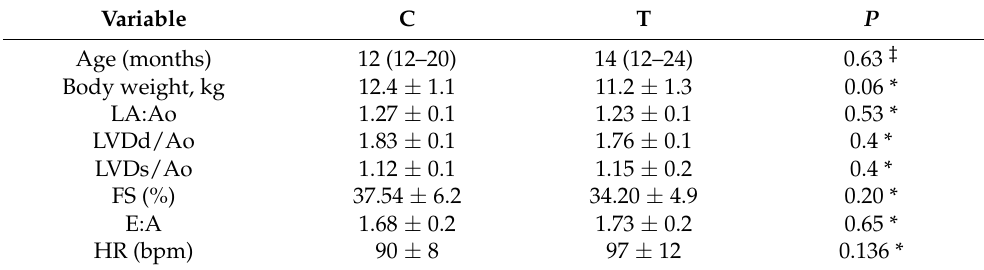
Table 1. Physical characteristics and echocardiography variables of dogs at the beginning of the trial. Variable